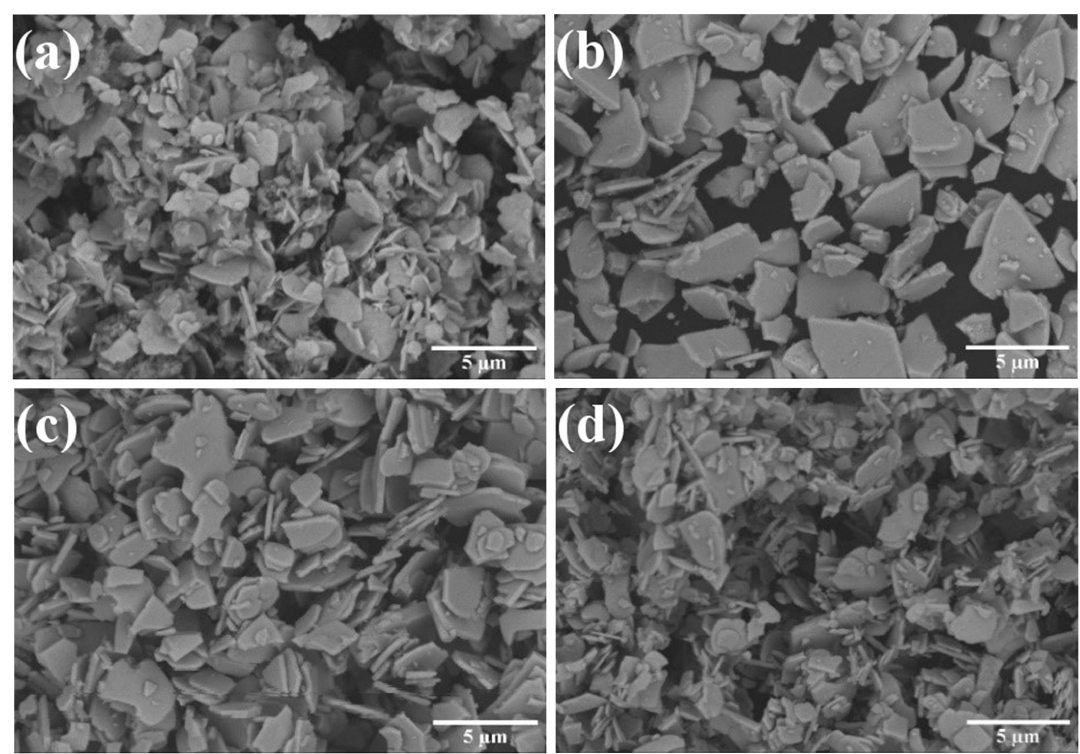
Bi LaTi Mn O powder. (a) x = 0 (b) x = 0.2 (c) x = 0.4, and (d) x = 0.6. 1- x 3+ x 4- x x 15